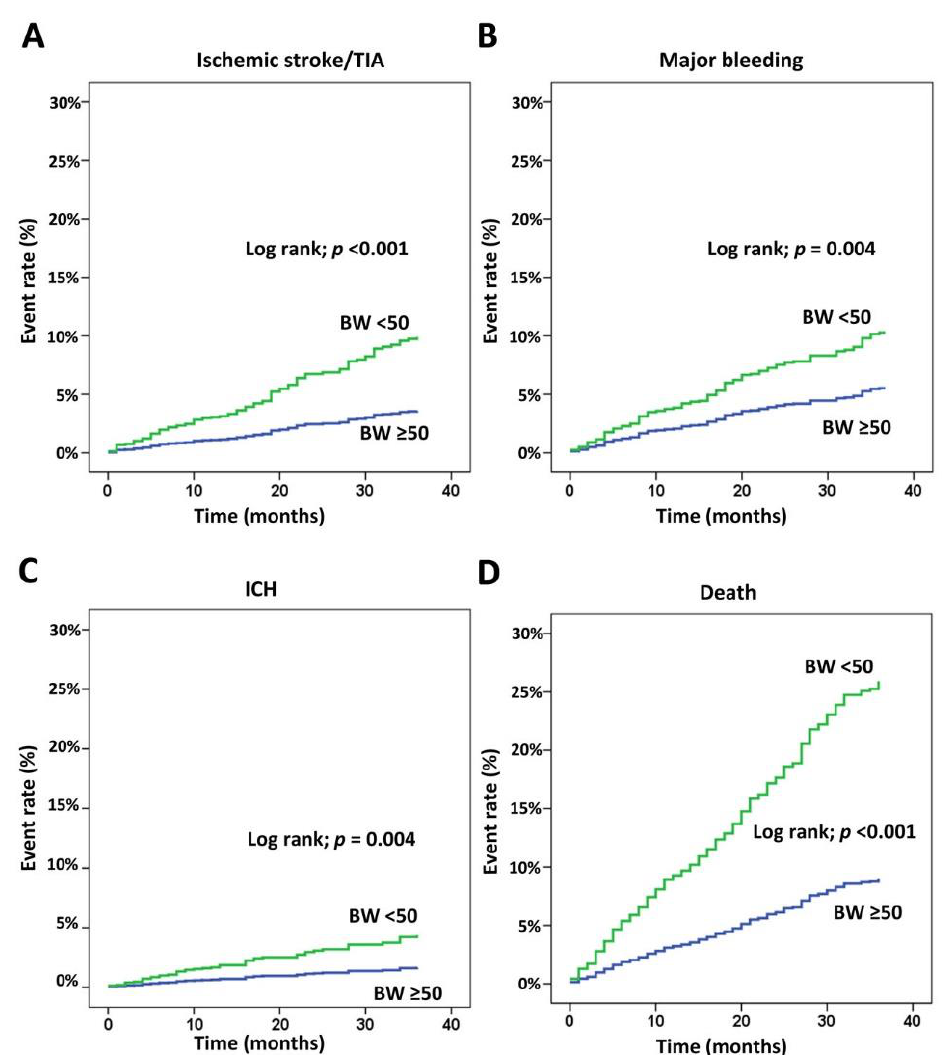
Figure 1. Cumulative event rate of ischemic stroke (IS)/transient ischemic attack (TIA) ( A ), major bleeding ( B ), intracerebral hemorrhage (ICH) ( C ), and death ( D ) compared between patients with body weight (BW) < 50 and ≥ 50 kg. A p -value < 0.05 indicates statistical significance. Kaplan-Meier graph with log-rank test was used for analysis. BW, body weight; TIA, transient ischemic attack. Regarding the cause of death, LBW had a higher rate of cardiovascular death (6.3% vs. 2.1%, p < 0.001). There was no significant difference in the rate of infection/sepsis and cancer as a cause of death